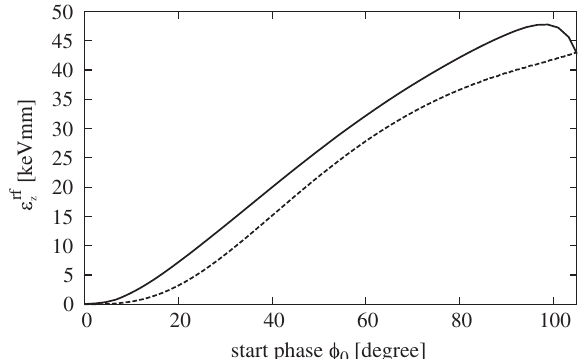
FIG. 9. Longitudinal emittance as a function of the start phase for a 1 1 cell rf gun; solid line, numerical result; broken line, 2 analytical result. For details, see the